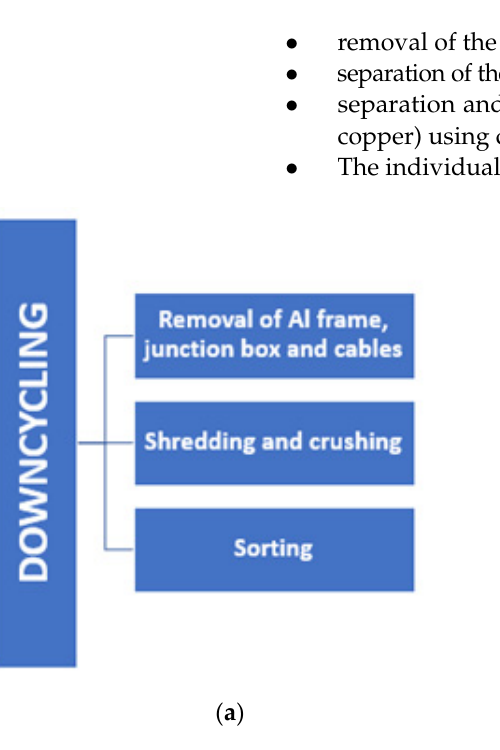
Figure 3. Methods of the crystalline PV modules recycling: ( a ) downcycling; ( b )